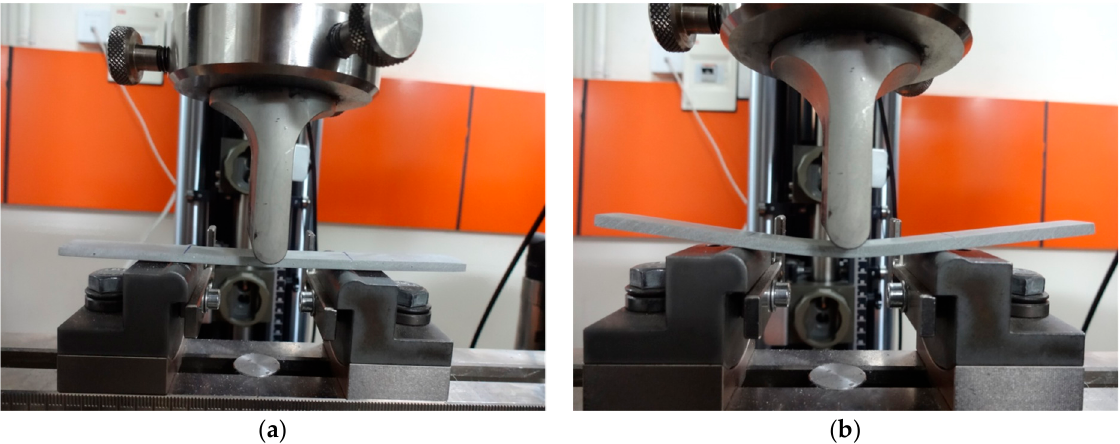
Figure 4. Images of test conduction on the specimens ( a ) before loading, and ( b ) during loading.